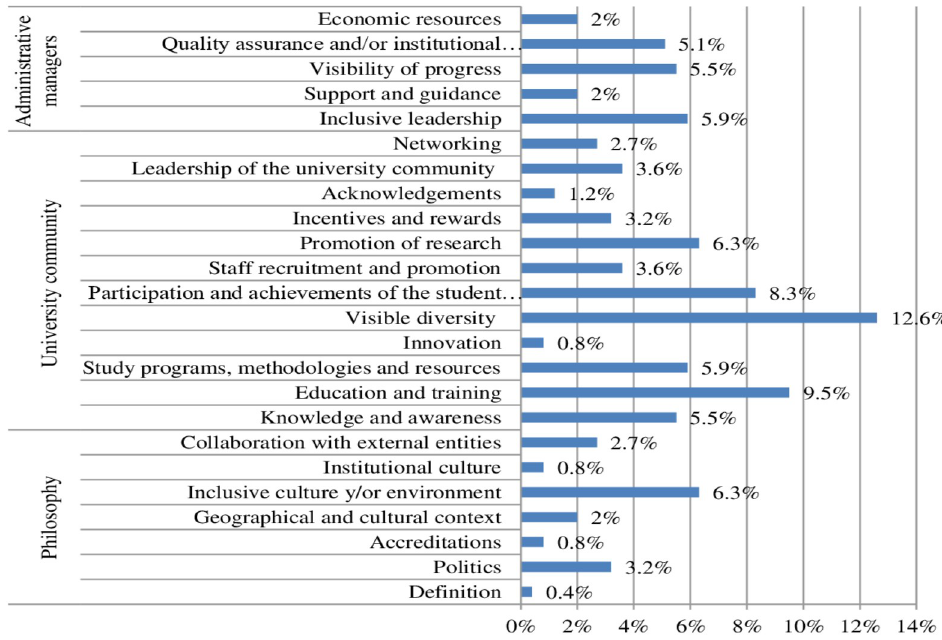
Fig 5. Distribution of frequency coding according to the goals of the strategic plans.